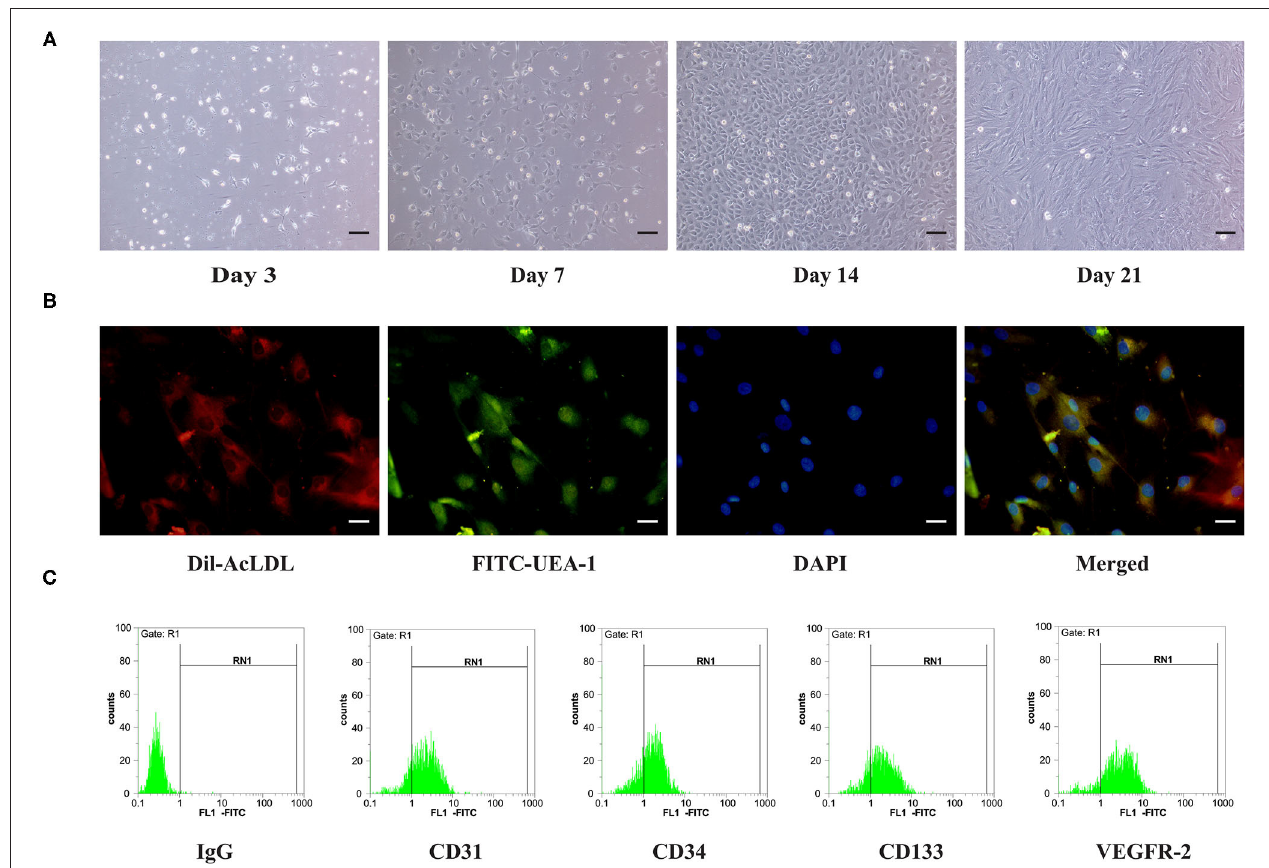
FIGURE 1 | Characterization of ApoE gene knockout rat bone marrow-derived EPCs. (A) On Day 3, Day 7, Day 14, and Day 21 of culture, the morphology of EPCs is observed under a microscope. Scale bar = 100 µ m. (B) EPCs taking up DiI-Ac-LDL could be visualized (red), immunofluorescence staining of EPCs positive for FITC-UEA-1 (green), nucleus (blue) was stained by DAPI. Scale bar = 50 µ m. (C) Cell surface markers (CD31, CD34, CD133, and VEGFR-2) of EPCs were investigated using flow cytometry.